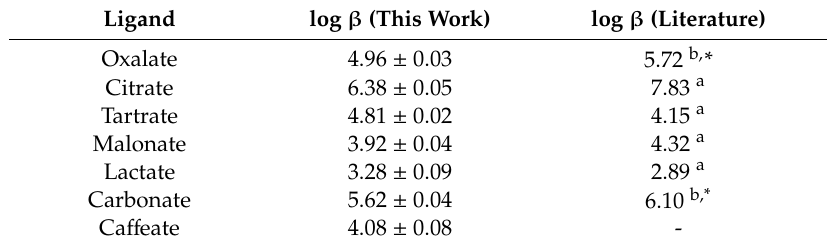
Table 1. Stability constants for the low molecular weight ligands determined in this study. Literature values for the stability constant are shown for comparison.